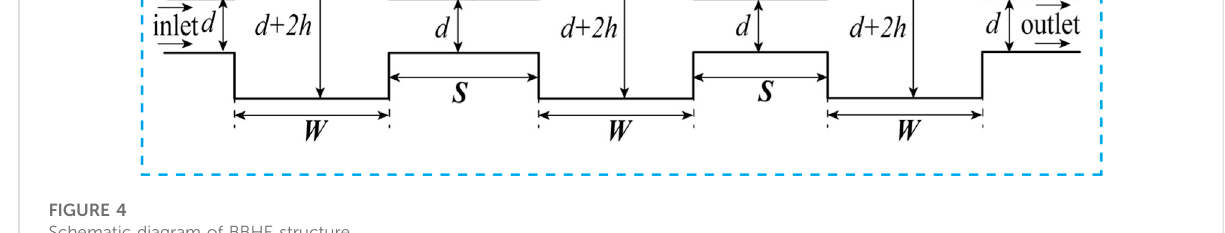
FIGURE 4 Schematic diagram of BBHE structure.